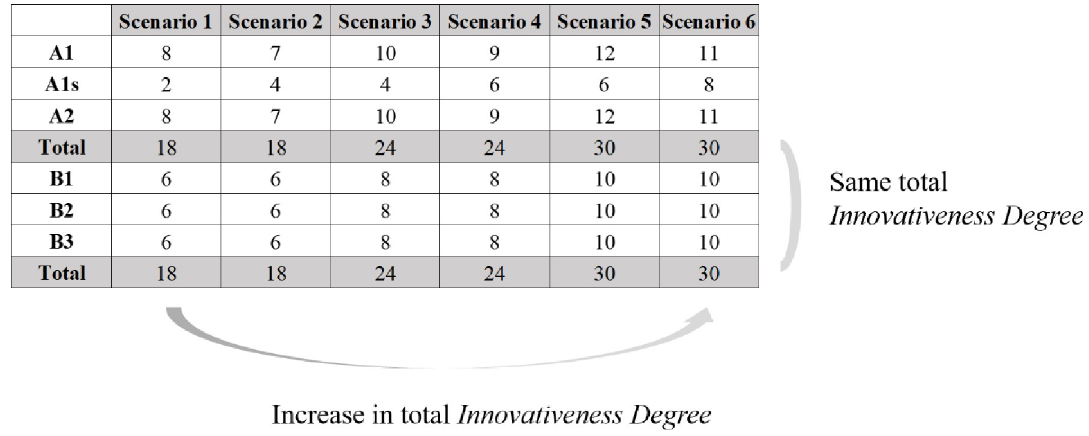
Fig 3. Scenarios according to the Innovativeness Degree of each